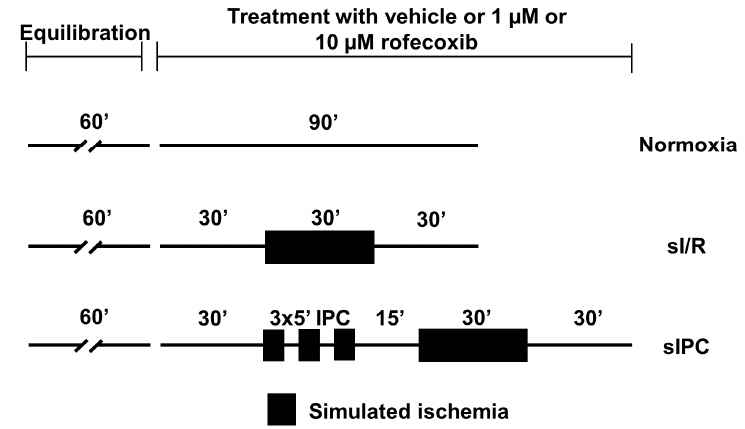
Figure 2. Ex vivo simulated ischemia / reperfusion (sI / R) injury study protocol: action potential parameters were measured in isolated rat left ventricular papillary muscles in normoxic, sI / R and simulated ischemic preconditioning (sIPC) conditions in the presence of vehicle or 1 or 10 µ M rofecoxib, respectively.